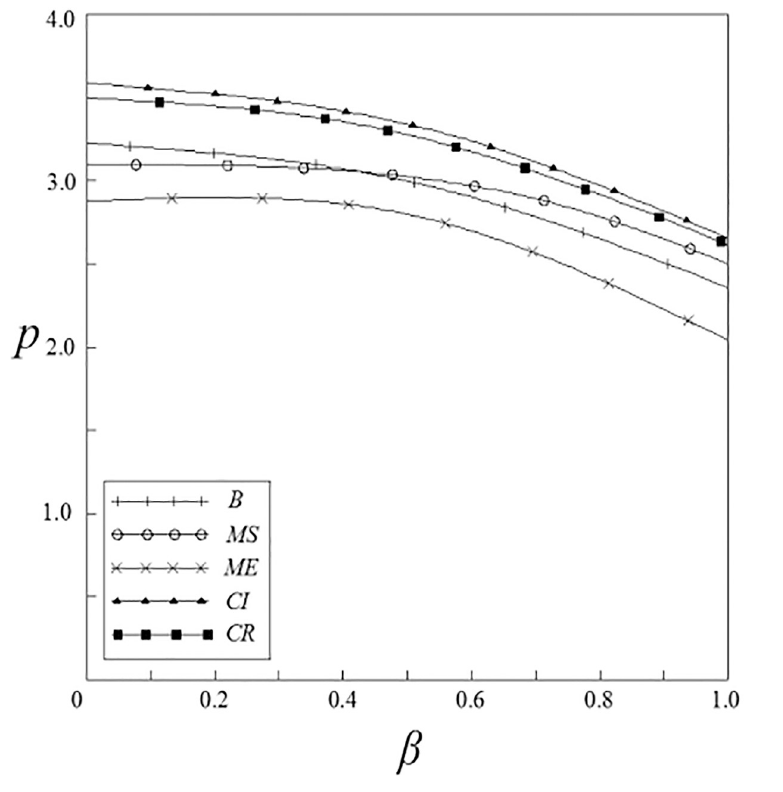
Fig 10. The relationship between p and β